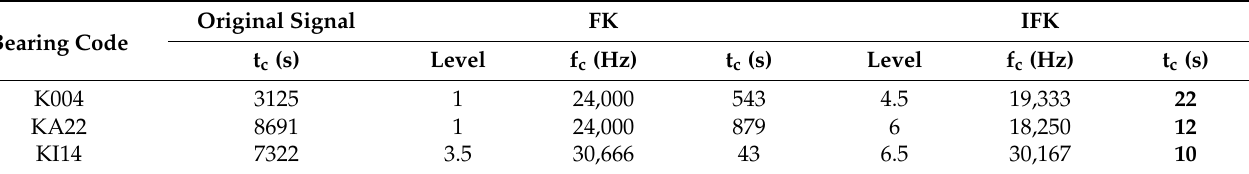
Figure 2. The best frequency band selected by ( a ) FK and ( b ) IFK. Table 1. Comparison of computational time.